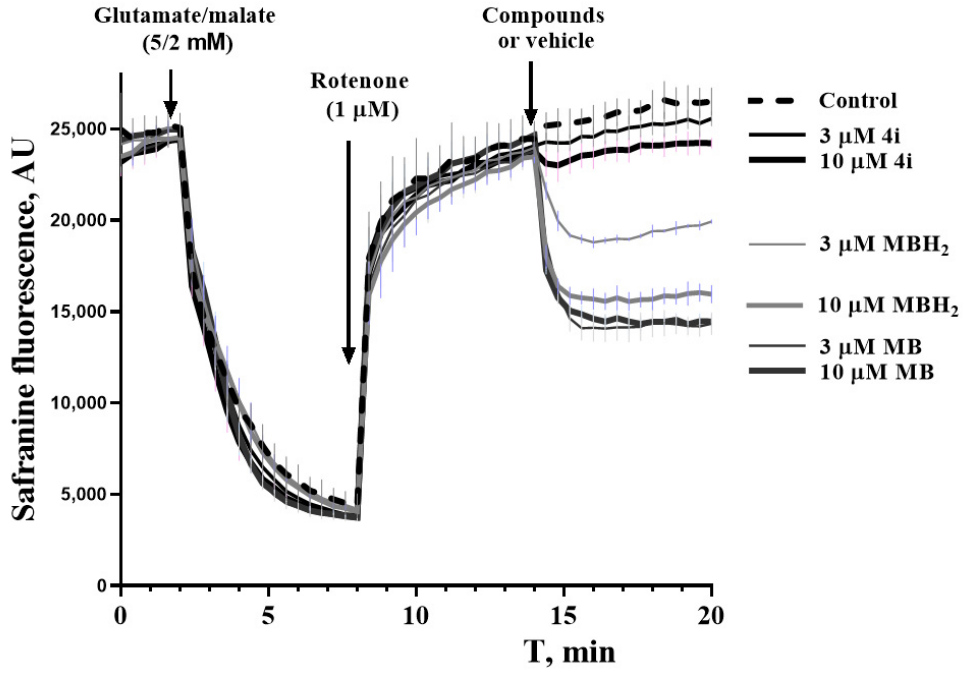
Figure 4. Bypassing properties of MB , MBH 2 , and 4i against the rotenone-induced depolarization of isolated rat liver mitochondria.